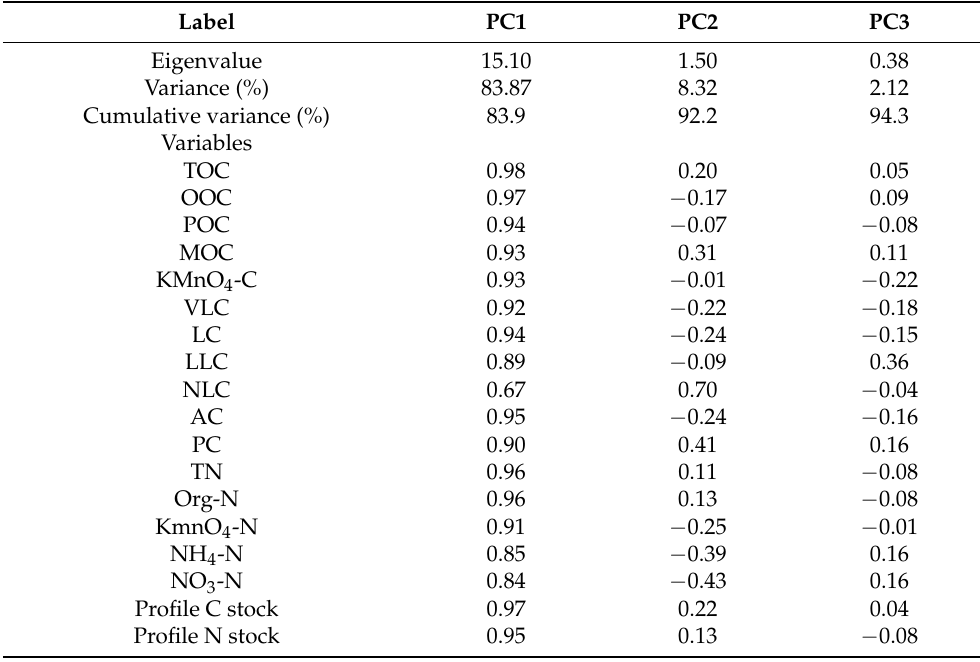
Table 8. Principal component (PC) study of soil organic carbon and nitrogen pools in a hot, arid environment under various land use systems.